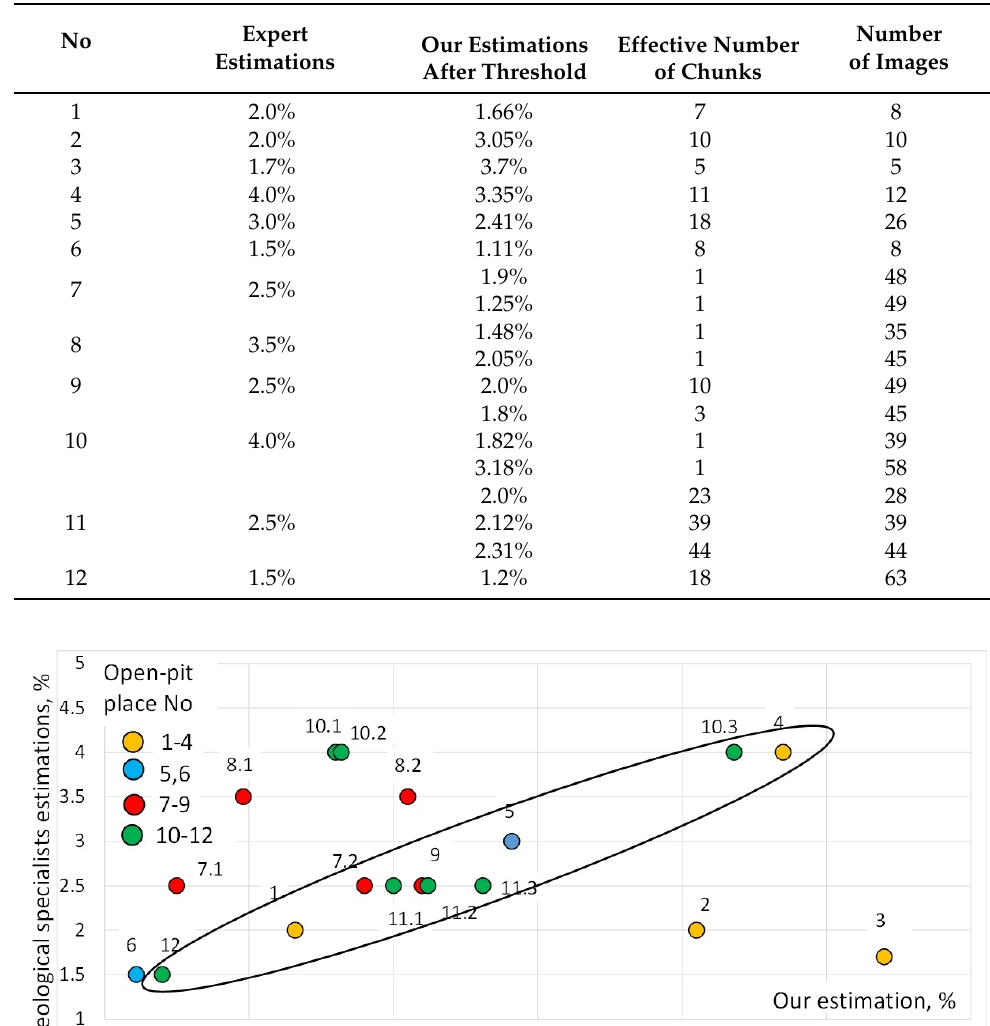
Table 5. Asbestos productivity estimation for test data with threshold.